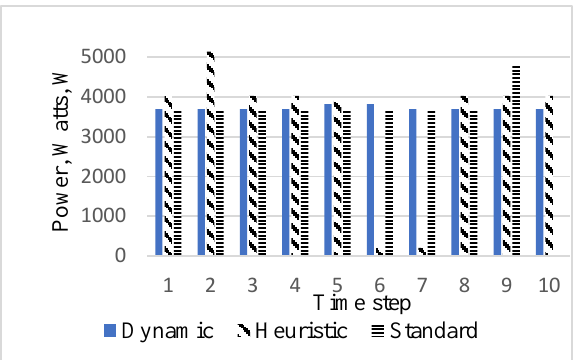
Figure 5. Power consumption comparison.